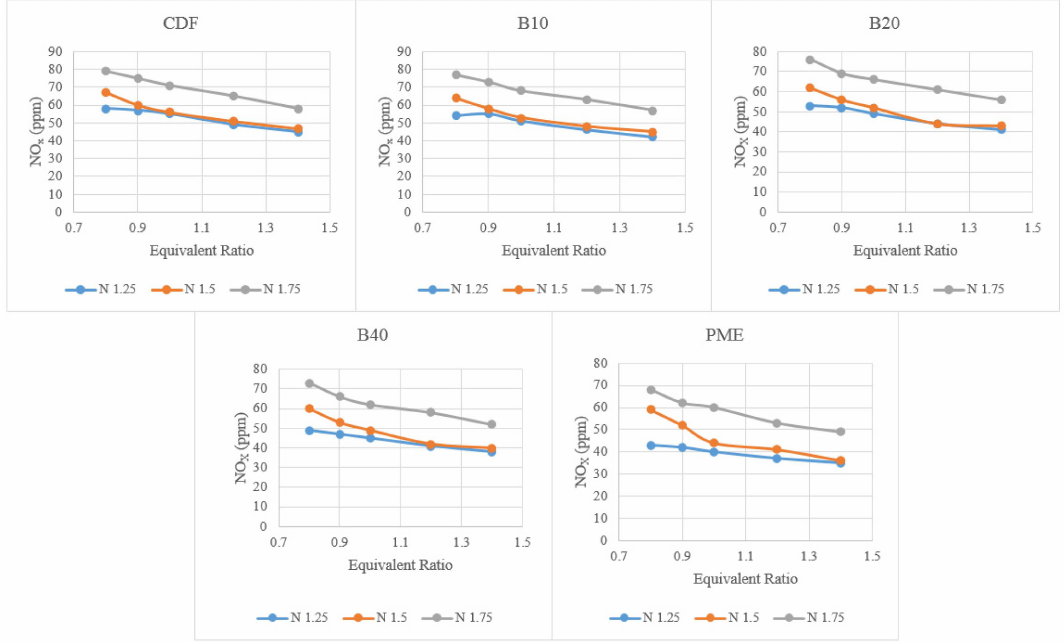
Figure 7. NO x emissions at various equivalence